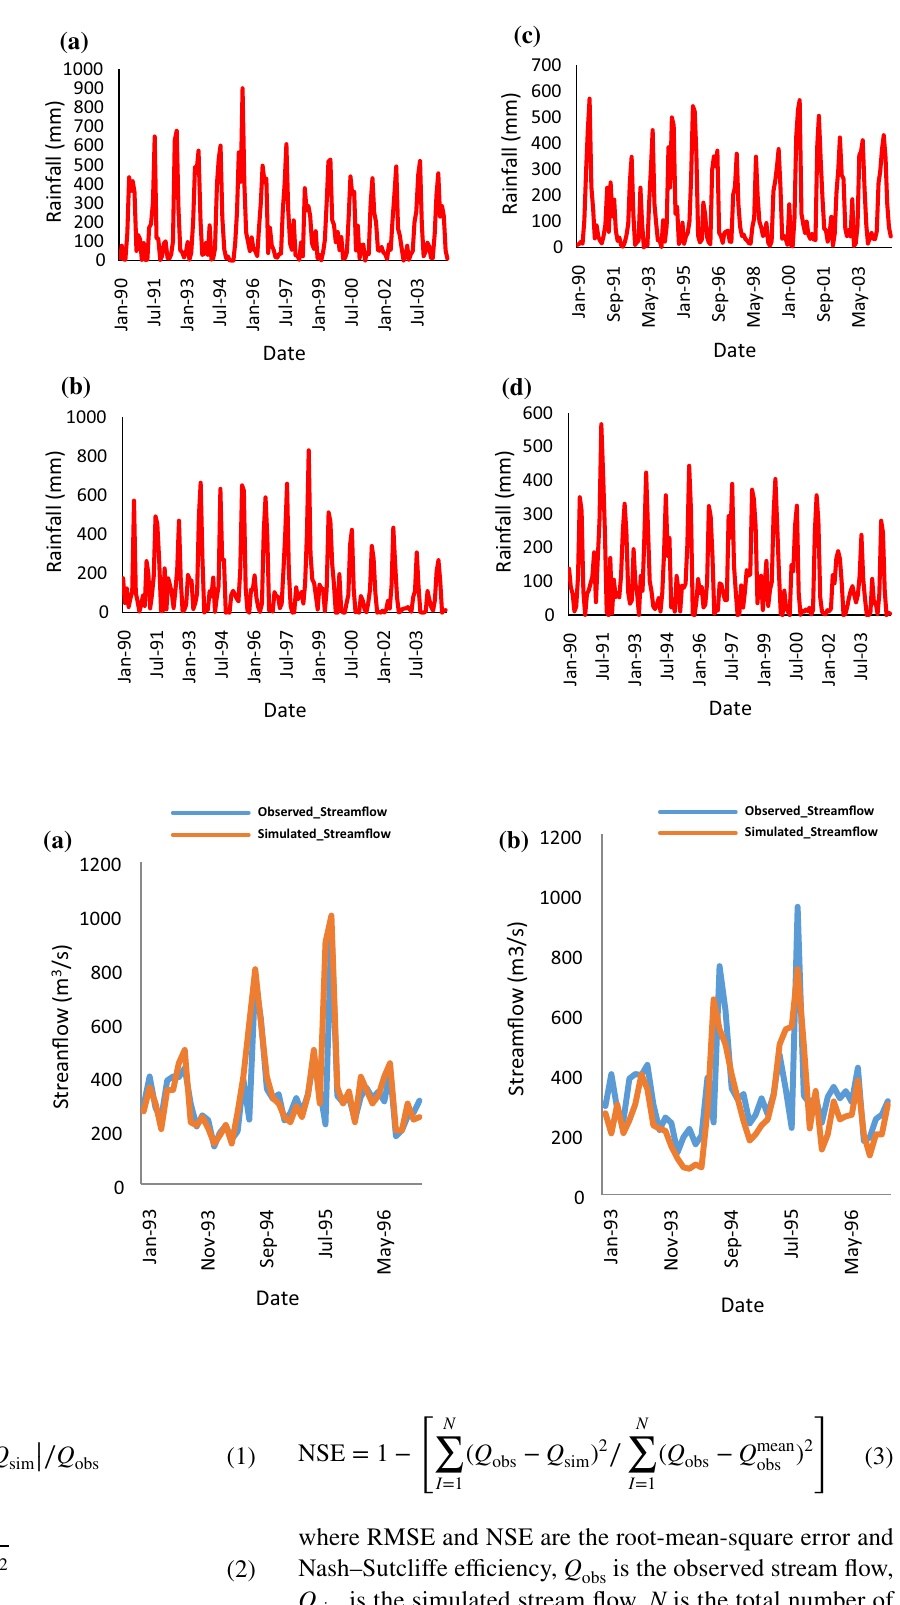
Fig. 10 Monthly rainfall data